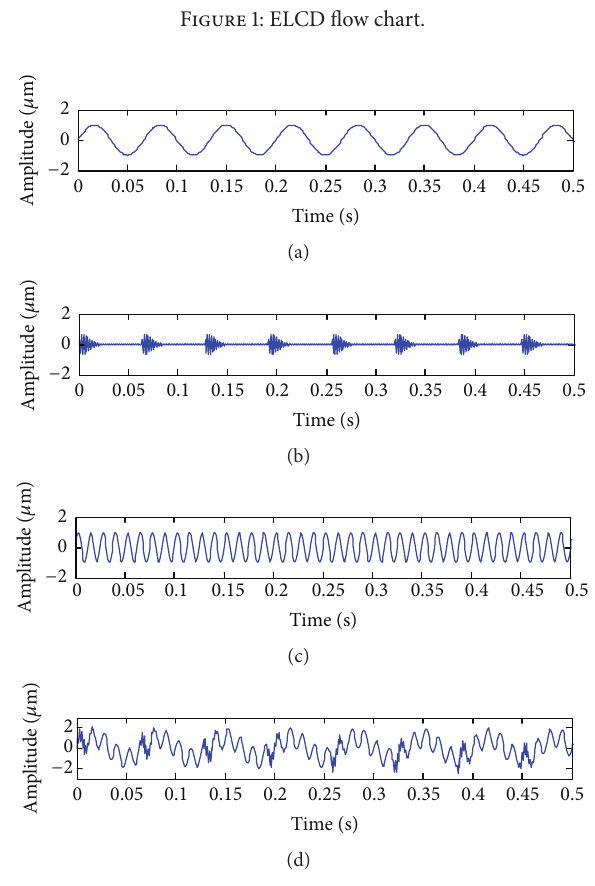
Figure 2: The simulation signal and its